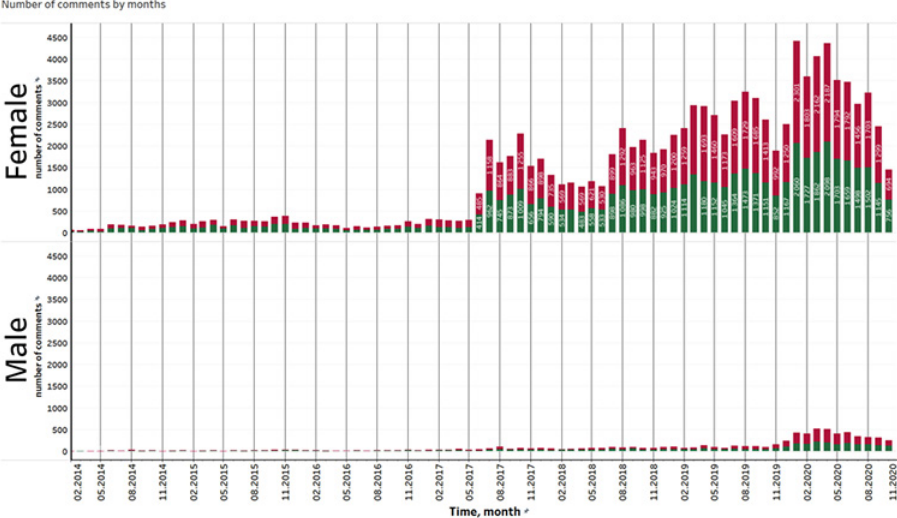
Figure 1. Distribution of the number of comments in the body by month. “Red” is negative com- ments, “green” is positive. Source : compiled by the authors in Tableau 19.3 based on gathered data from the social network